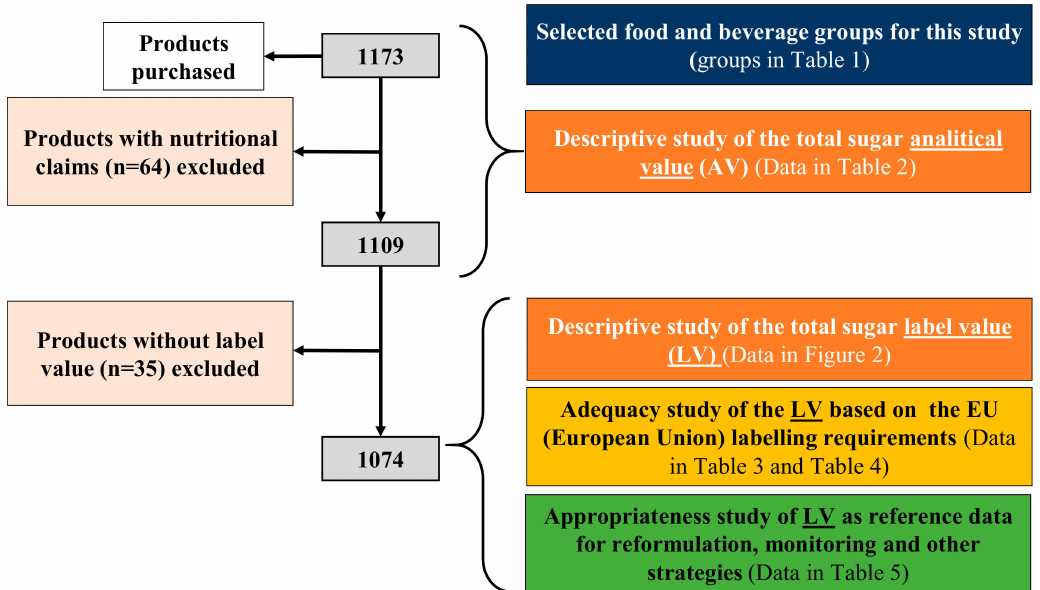
Figure 1. Flow diagram. Sample selection and the di ff erent analyses carried